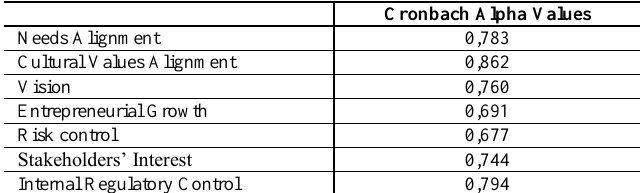
Table 4: Internal reliablity